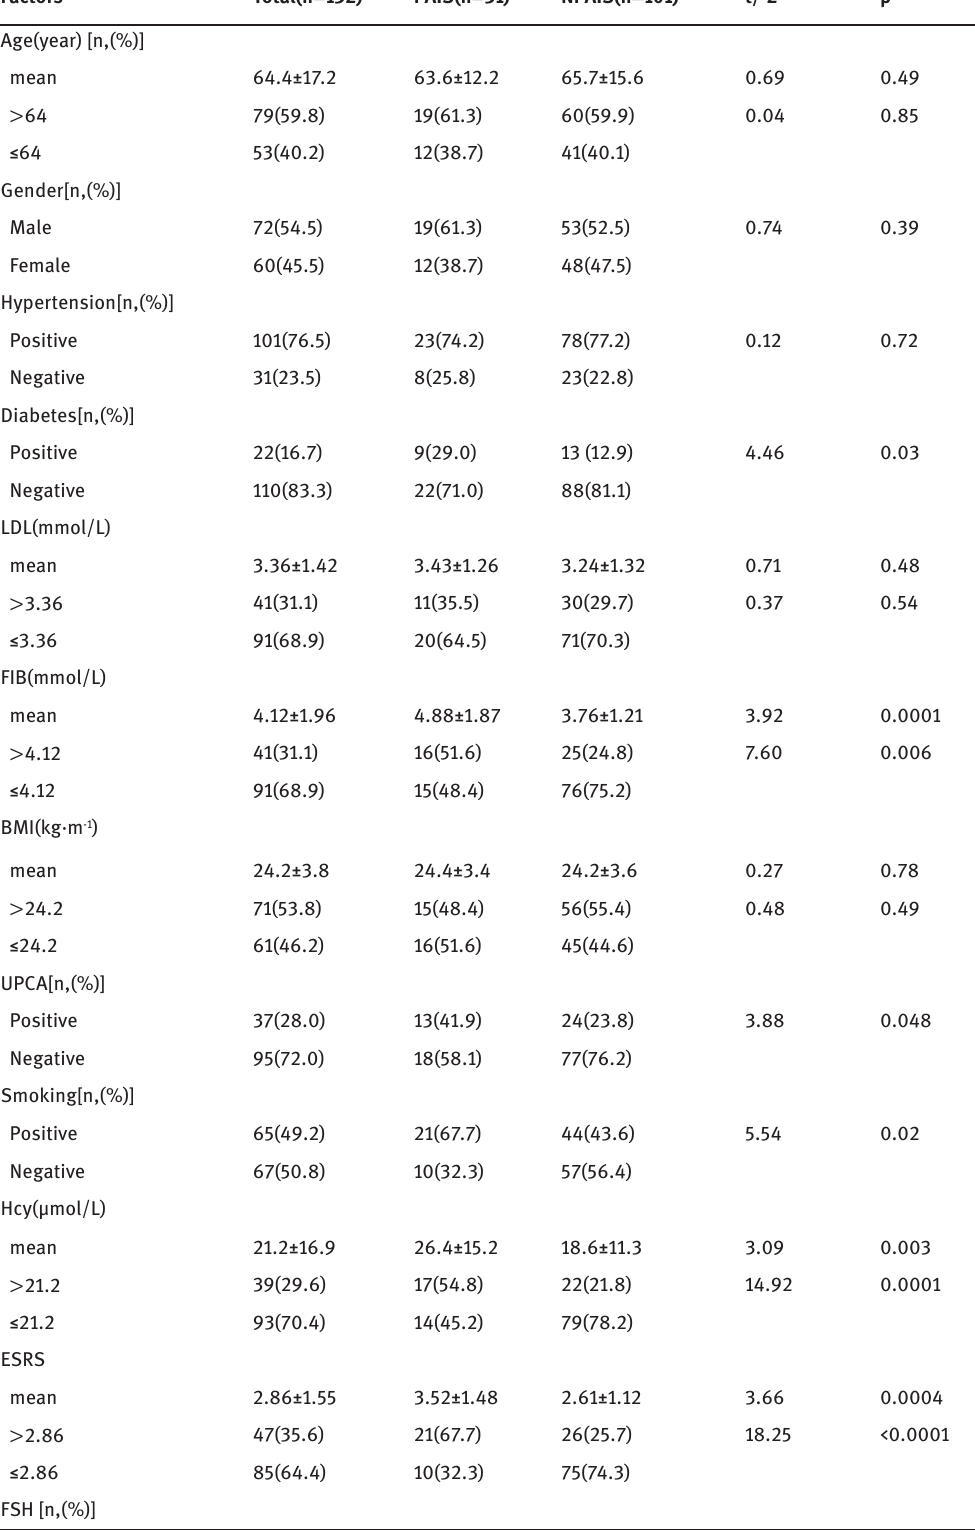
Table 1: The clinical factors comparison between the PAIS and NPAIS